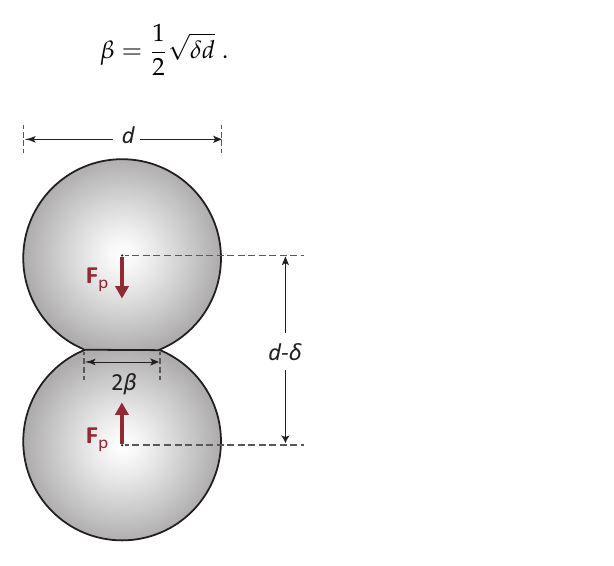
Figure A1. geometry of the problem of two elastic spheres in contact under the action of an applied compressive